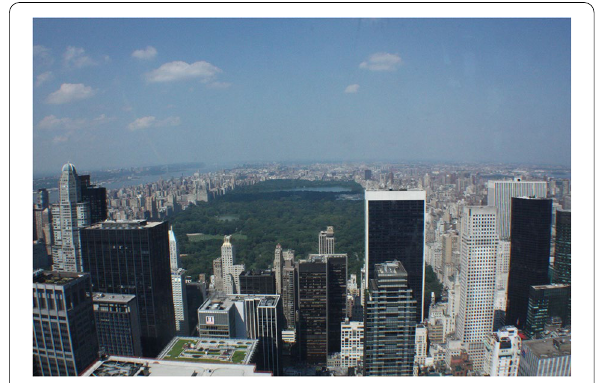
Fig. 3 Tamed nature in Central